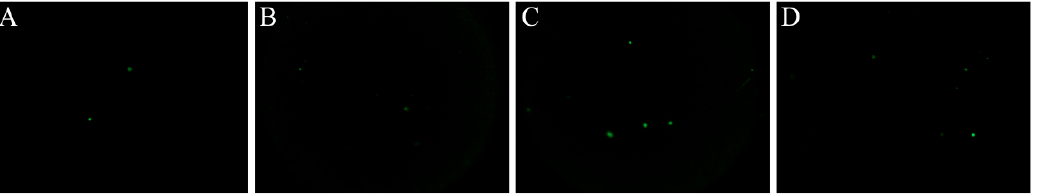
Figure 5. DNA fragmentation profiles of DNA extracted from Vibrio parahaemolyticus . Lane: M, λ /HindIII DNA marker; 1, untreated; 2, treated with 405 nm LED irradiation for 30 min; 3, treated with 0.1 mg/mL of citral for 30 min; 4, LED treatment combined with 0.1 mg/mL of citral for 30 min. 4. Discussion The present study detected the effectiveness of 405 nm LED combined with 0.1 mg/mL of citral in inactivating V. parahaemolyticus on the shrimp surface to see if the LED technology has a potential to be applied to seafood preservation. Moreover, the bacterial membrane damage and DNA breakage of V. parahaemolyticus were determined to reveal the mechanism of the inactivation by 405 nm LED and citral. LED with a specific wavelength (405 nm) has been proven to have a microbial inac- tivation effect [10,35,36]. The optimized LED sterilizing device in this study has a power of 20 W, a wavelength of 405 ± 5 nm, and was sterilized at 4 °C to simulate a practical food storage condition. Citral is a kind of edible plant-derived bacteriostatic agent whose anti- microbial action against some common pathogens has been demonstrated. Somolinos et al. [37] showed that citral at 0.2 μ L/mL caused more than a 5 log CFU/mL E. coli cells’ reduction at pH 4.0 for 24 h. Citral also showed antimicrobial activity against L. monocyto- genes , C. sakazakii, and V. parahaemolyticus at relatively low concentrations. The MICs of citral against L. monocytogenes strains ranged from 60 to 300 μ g/mL [38]. The MIC of citral against C. sakazakii strains was 0.6 μ L/mL [37]. In Guo’s study, the MICs of citral against V. parahaemolyticus ATCC 17802 was 0.1 mg/mL [38]. For this reason, we chose 0.1 mg/mL